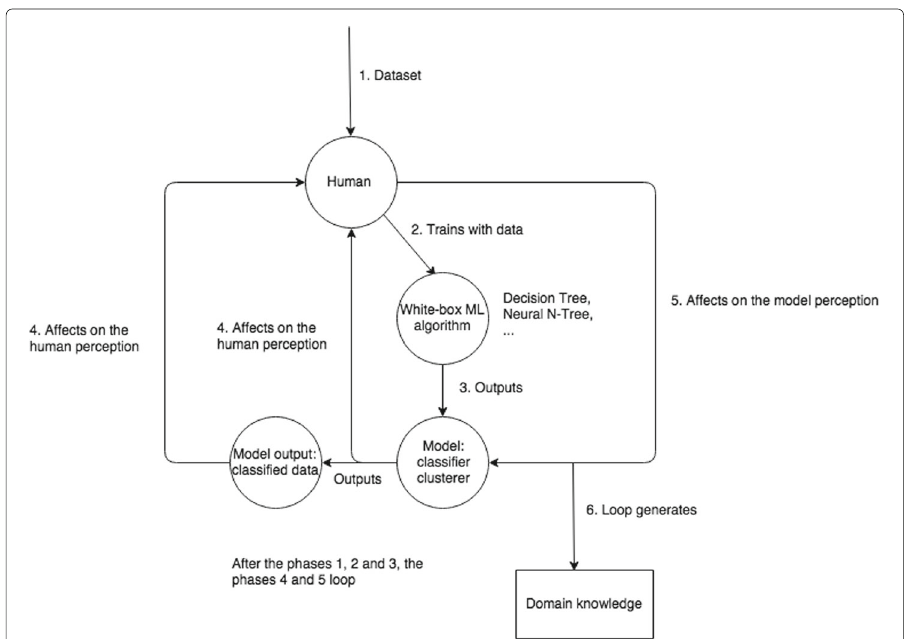
Fig. 4 Augmented intelligence in the educational data mining